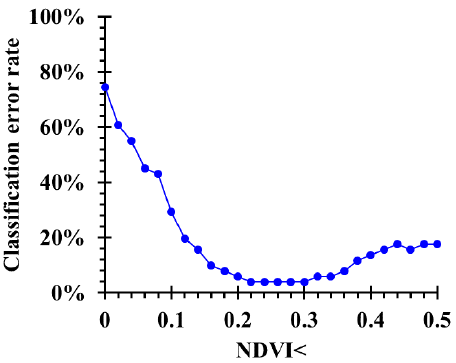
Figure 11. The classification error rate with different values for the omitted water.